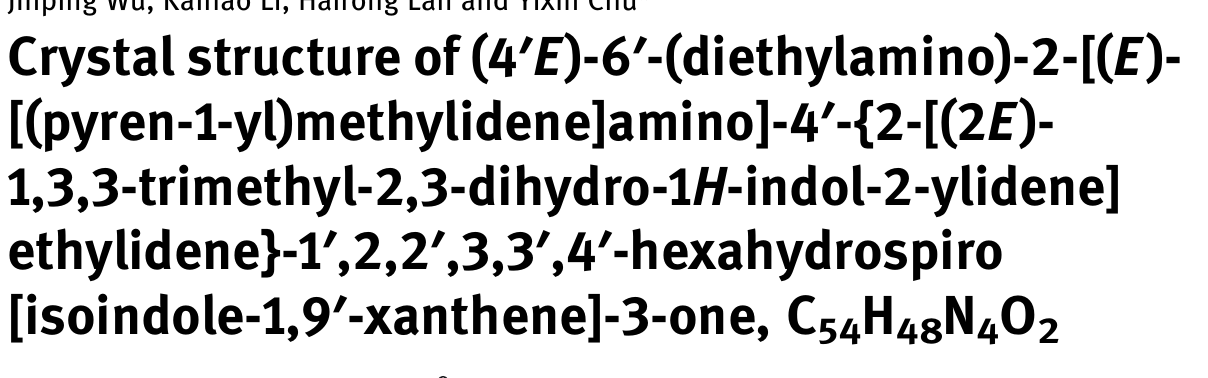
Table  : Data collection and